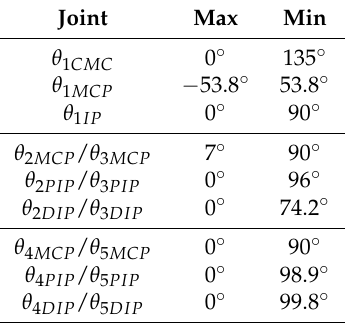
Figure 13. PUT-Hand kinematics with basic dimensions and joint naming: red—fully actuated joints, yellow—dependent joints, violet—underactuated joints. Table 4. Joint angle